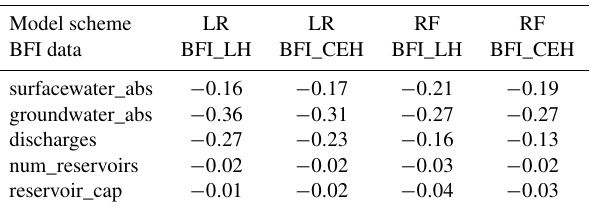
Table 2. Pearson correlation between Set A model residuals and Set B model